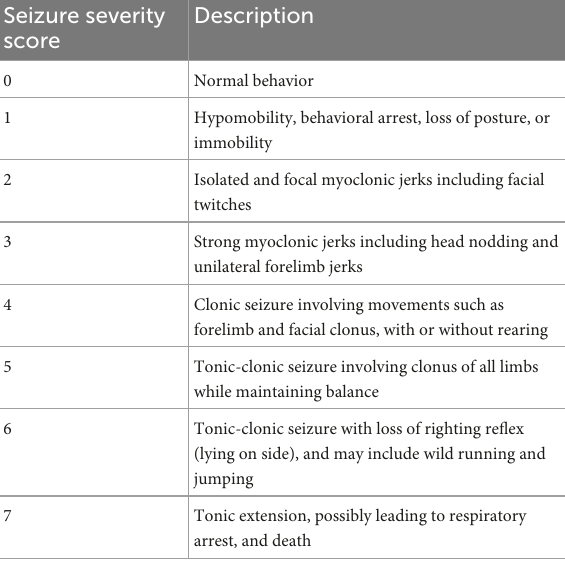
TABLE 1 Modified seizure severity